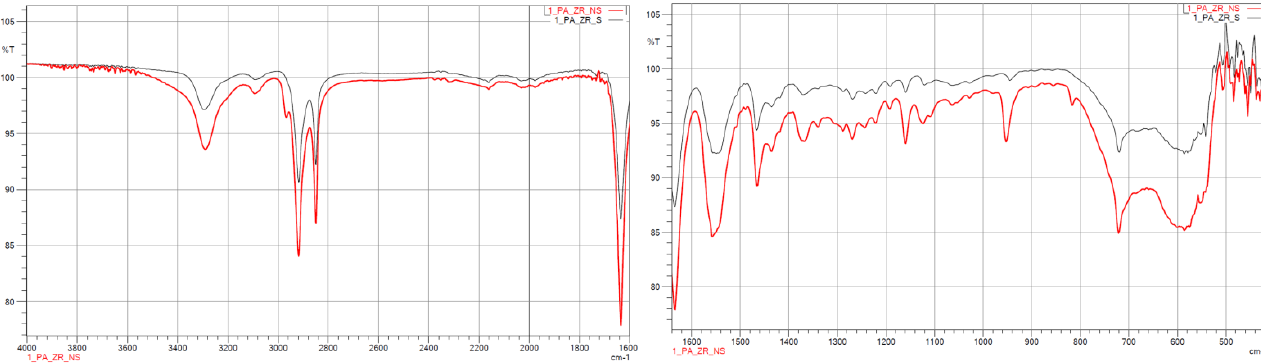
Figure 8. IR spectra for PA12_ZrO 2 non ‐ sterilised (red curves) and sterilised (black curves) samples.